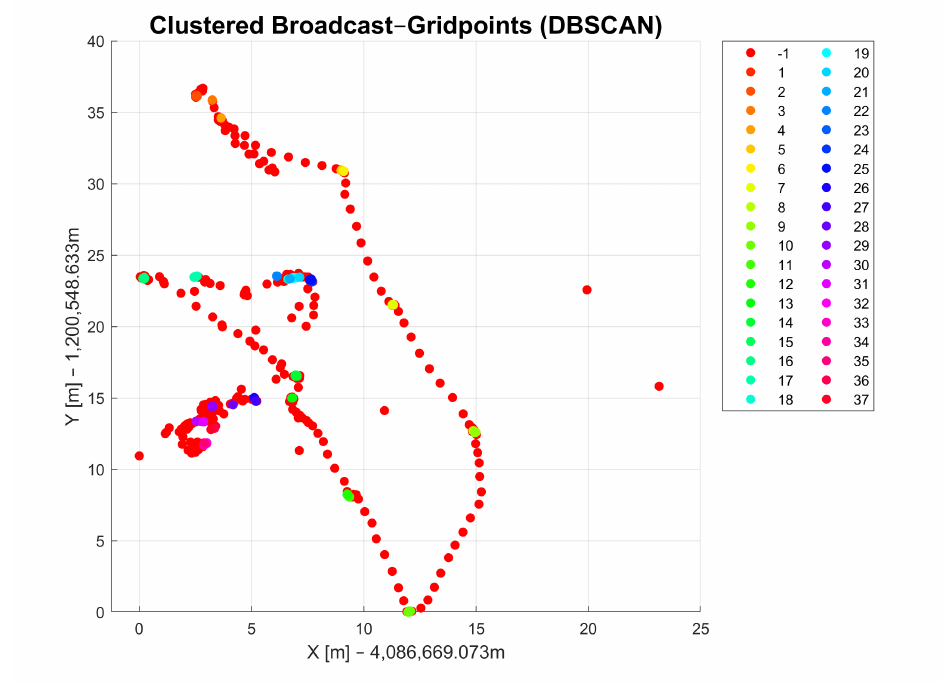
Figure 5. Results of DBSCAN